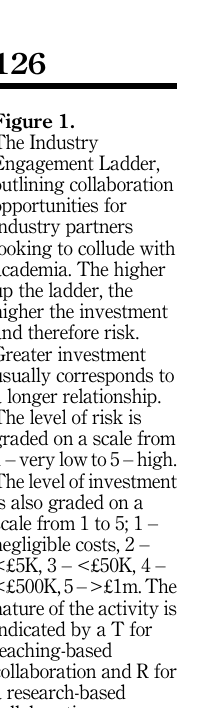
Figure 1. The Industry Engagement Ladder, outlining collaboration opportunities for industry